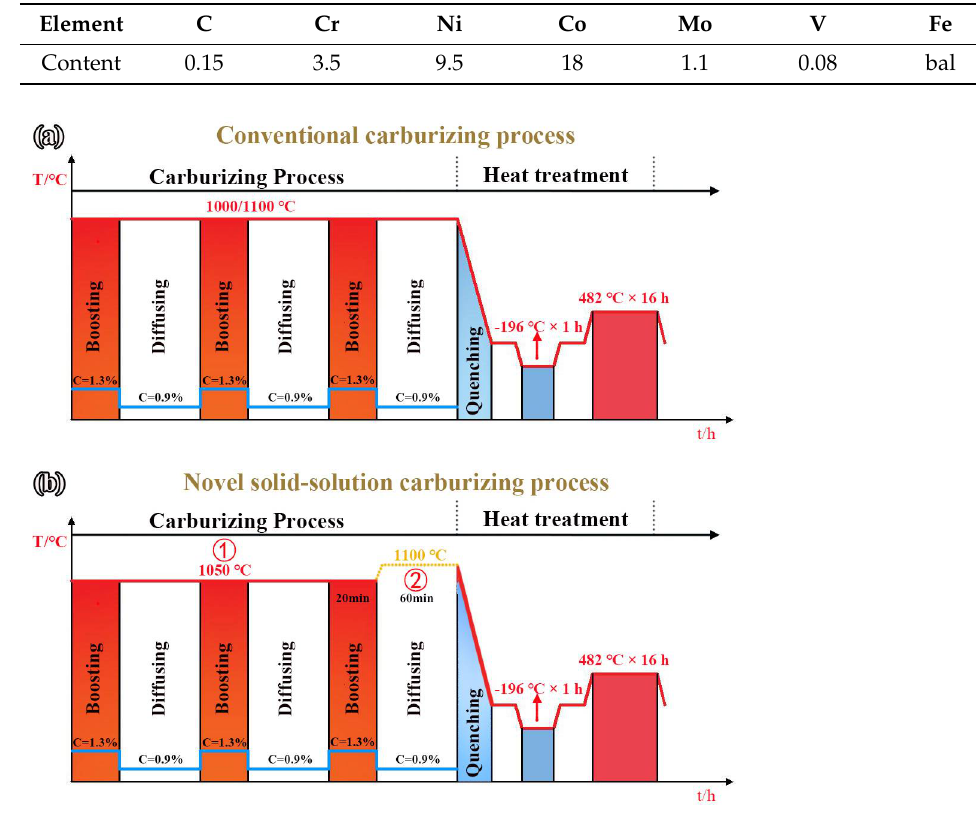
Figure 1. Schematic diagram of carburizing process: ( a ) conventional carburizing process; ( b ) novel solid-solution carburizing